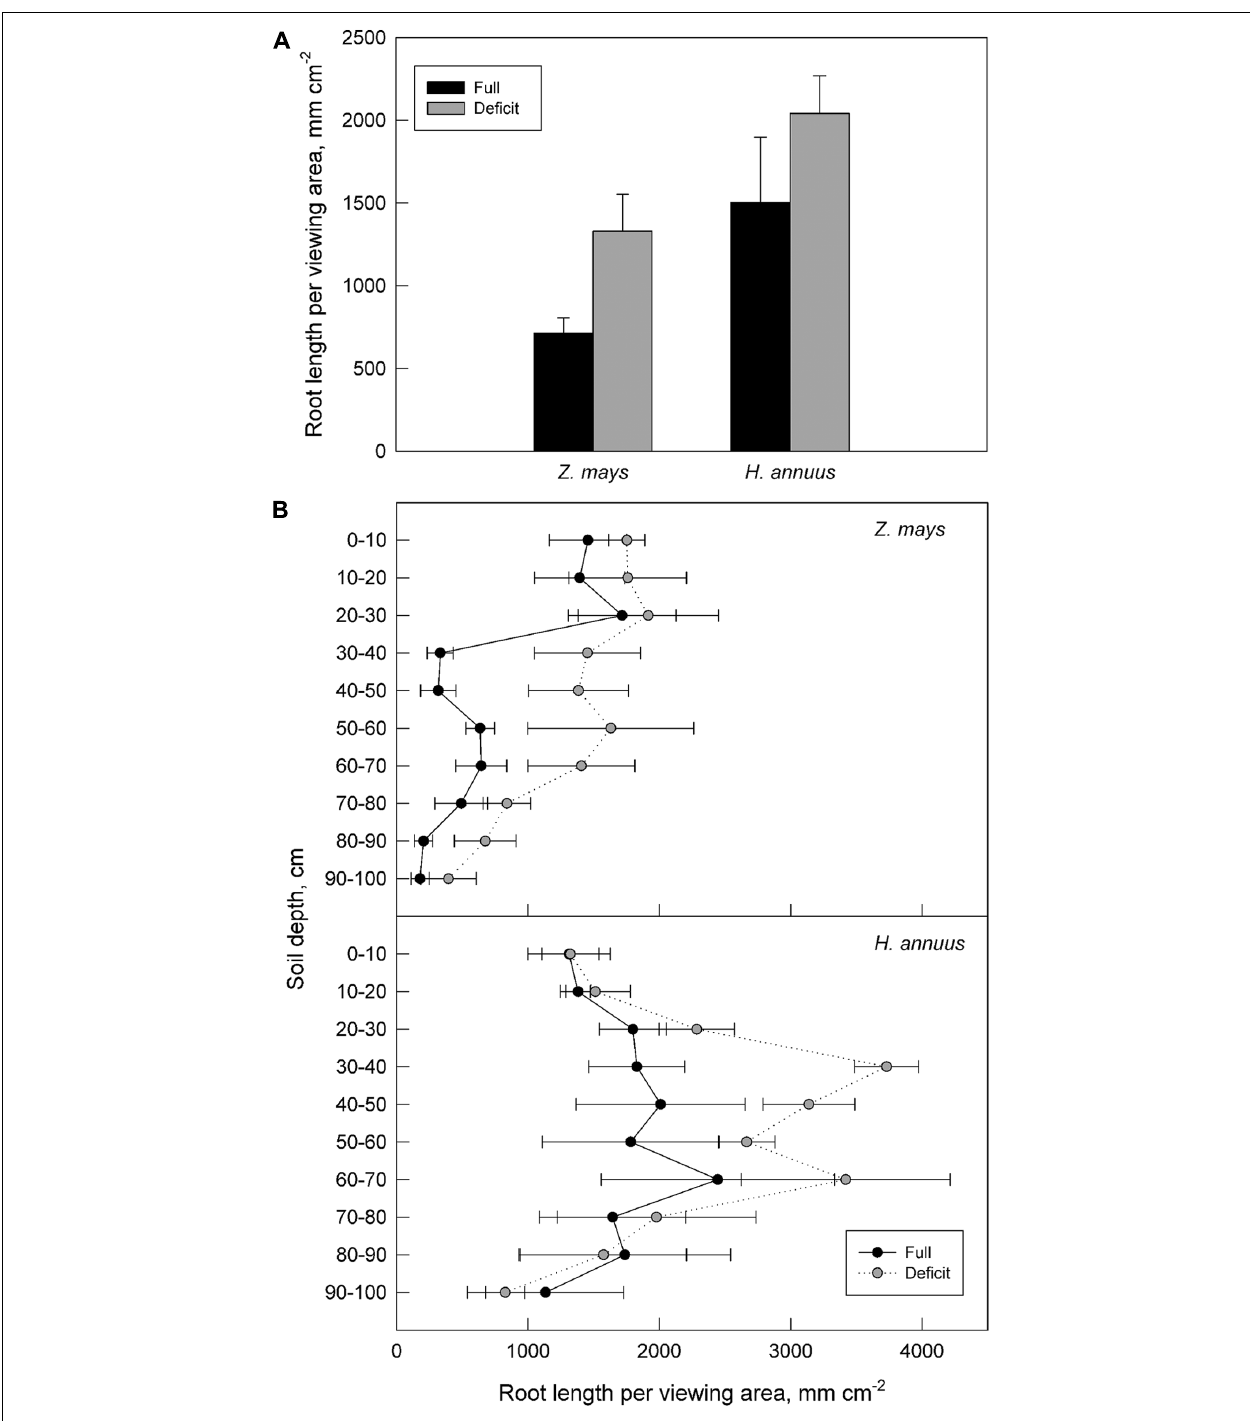
(B) are given. Each bar and point represents root growth averaged among four minirhizotron tubes per treatment, with each tube installed in a different treatment plot. Soil at the site is a sandy loam. Annual precipitation is approximately 350 mm. Irrigation is applied